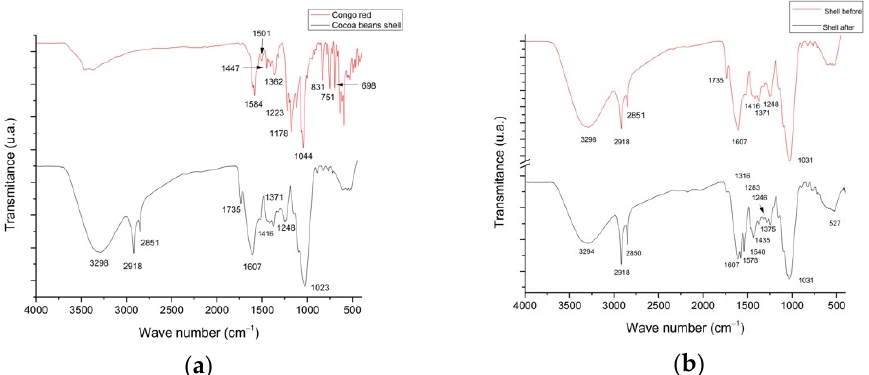
Figure 2. FTIR spectra of Congo red dye and cocoa bean shells ( a ) and of cocoa bean shells before and after the Congo red dye adsorption process ( b ).